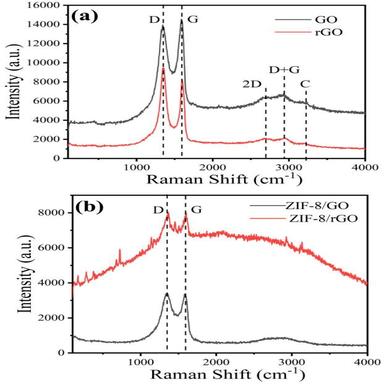
Raman spectra for (a) GO and rGO, (b) ZIF-8/GO and ZIF-8/ rGO composites.